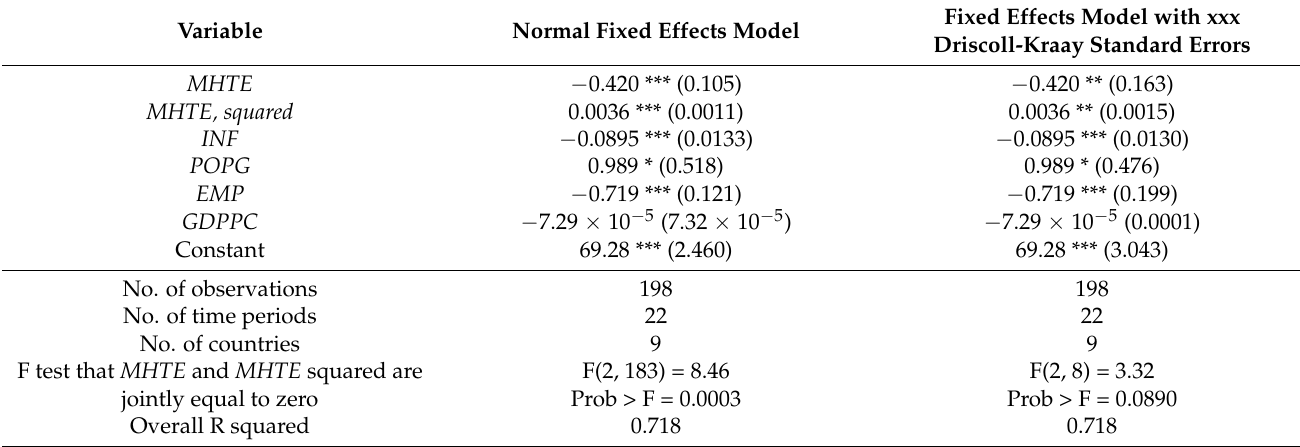
Table 3. Impact of medium- and high-tech export on renewable energy